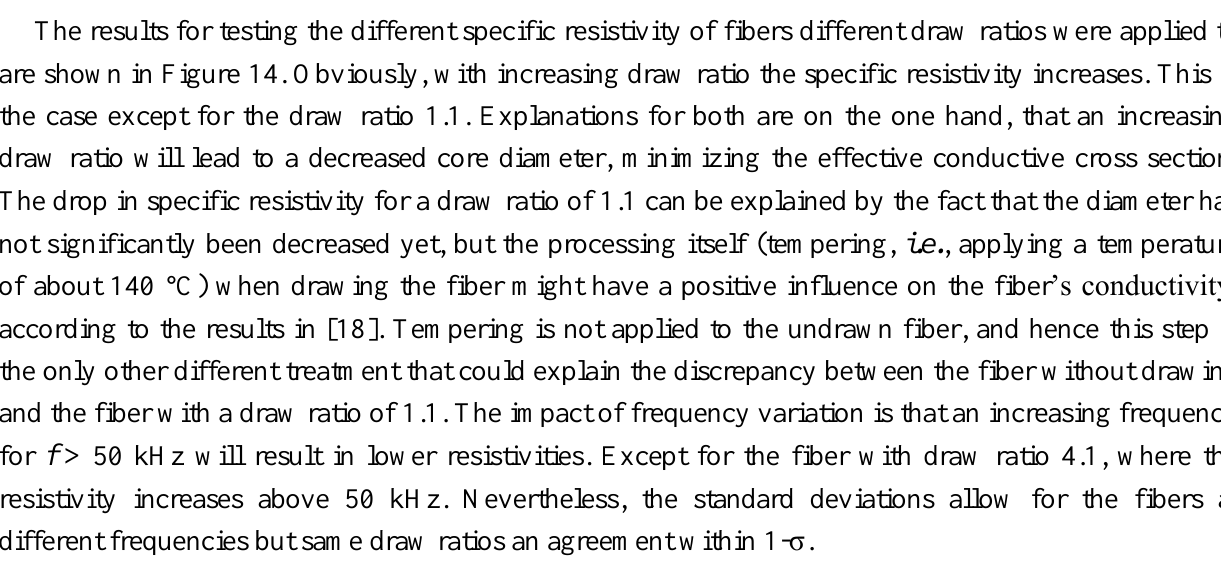
Figure 14. Behavior of fiber resistivity with increasing draw ratio for different applied